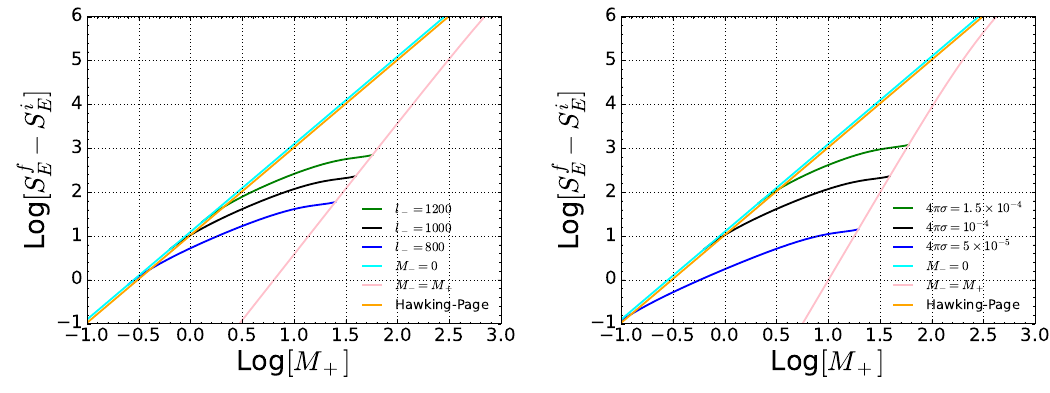
Figure 8 . Difference of action in units of G = 1 for ℓ + = 10000 as a function of M + . On the left we plot various inside AdS lenght scale, i.e. ℓ − = 800 , 1000 , 1200, and on the right we change the surface energy density, that is 4 πσ = (15 , 10 , 5) 10 − 5 . In green and pink we show the upper × and lower bound for the outside mass respectively. The probability for the Hawking page phase transition, i.e. the black hole decay to radiation, is plotted in orange. Note that all parameters can be rescaled with M and then the action must be multiplied by a factor 4 M 2